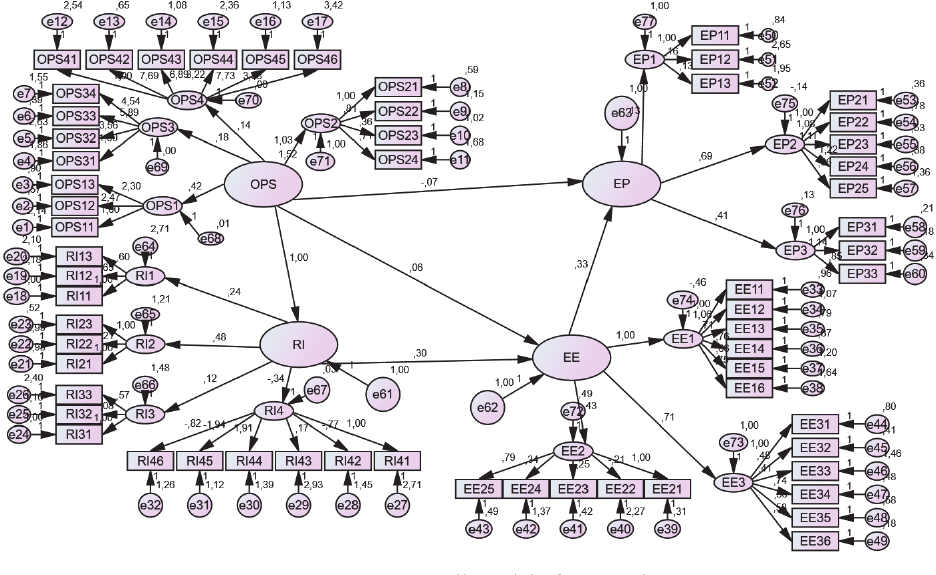
Fig. 2. Full Model of